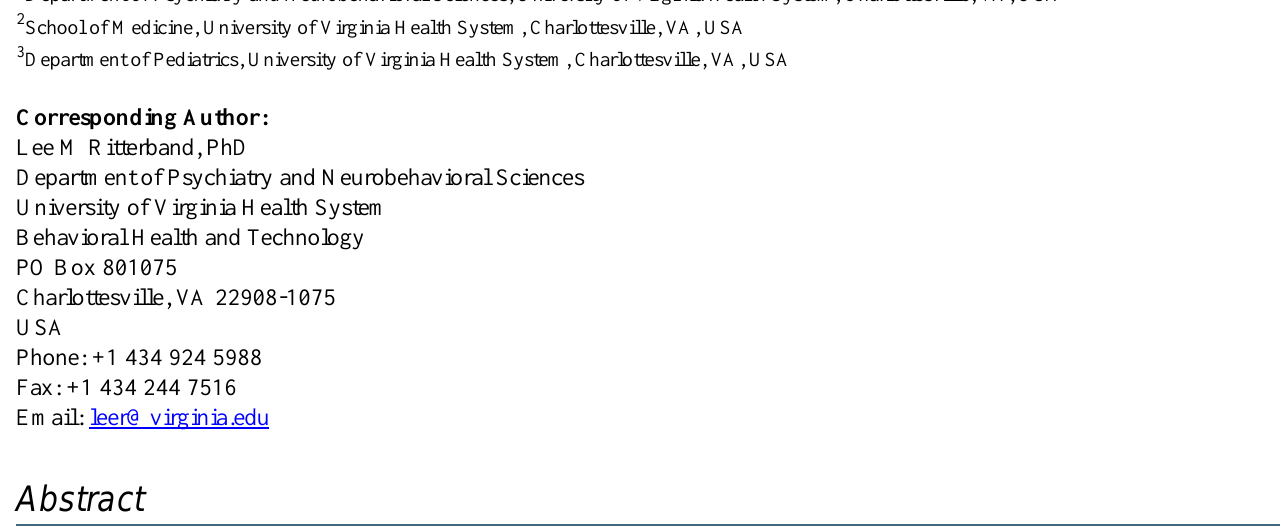
Internet; behavioral intervention;